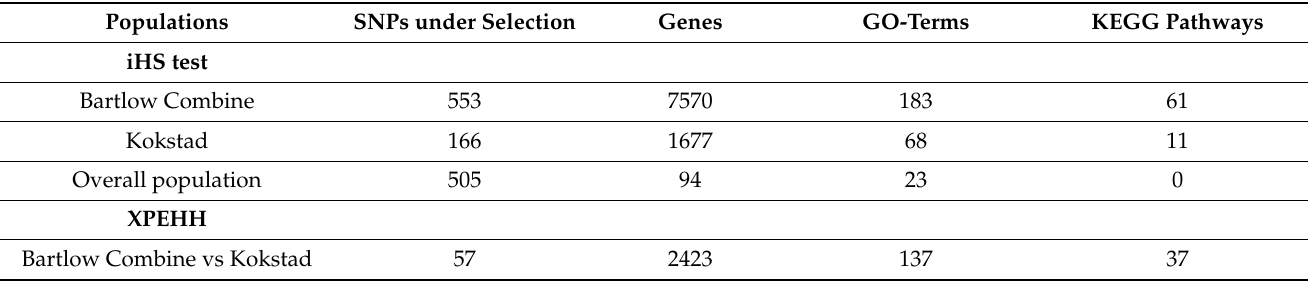
Table 4. Regions under positive selection in both